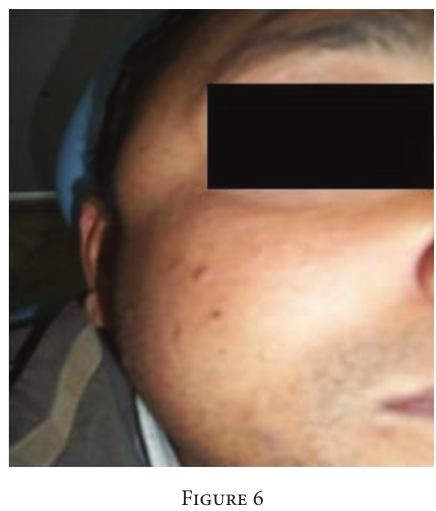
Tab albendazole 400 mg BD along with Crocin SOS for 4 weeks. The patient completely recovered and was completely asymptomatic after 4